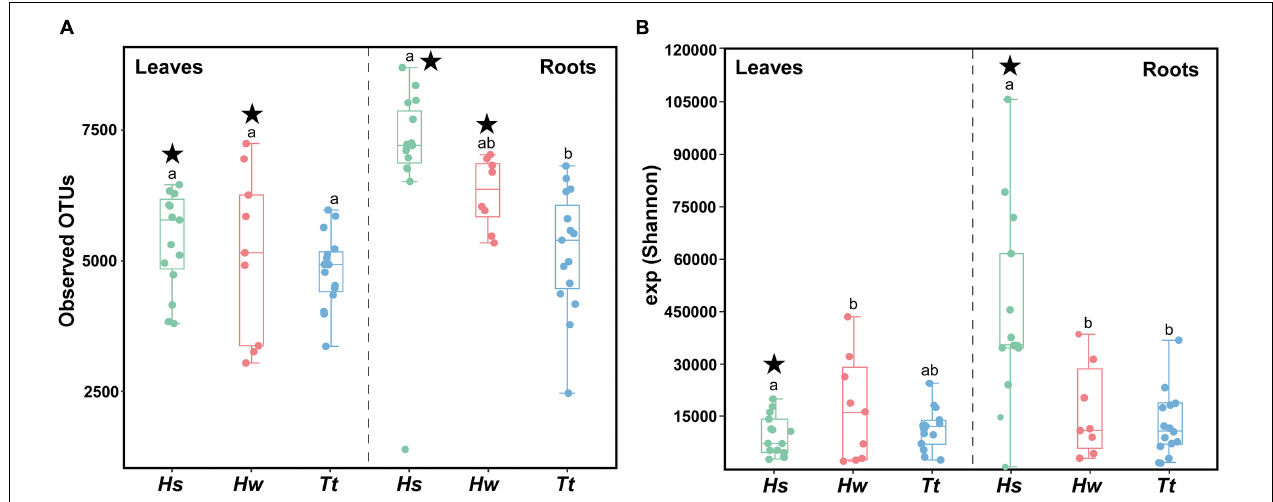
FIGURE 2 | Boxplot for the bacterial α -diversity using (A) observed OTUs and (B) exponentiated Shannon Diversity Indices of bacterial communities associated with the different tissues of the three seagrass species based on Illumina 16S rRNA gene amplicon sequencing. Hs— Halophila stipulacea , Hw— Halodule wrightii , Tt— Thalassia testudinum . The line within the box represents the median, and the bottom and top boundaries of the box represent the 25th and 75th percentiles, respectively. The whiskers represent the lowest and highest values within the 1.5 interquartile range (IQR). Different lowercase letters indicate significant differences in mean value for species within tissues at p < 0.05. Stars mark significant differentiation of tissues within species at p < 0.05. Graphics were manipulated to both fit in the same figure. In addition, colors were changed so the different species’ colors would match with the other figures.